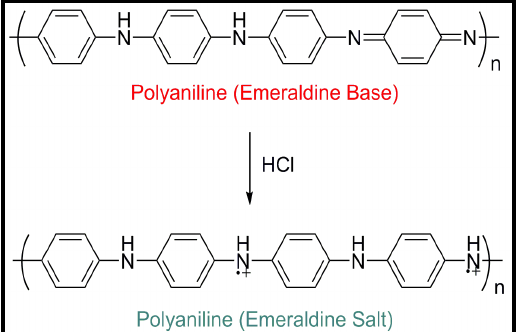
Figure 5. Chemical structure of polyaniline (emeraldine base) and transformation to a conductive salt by prototonation in an acid